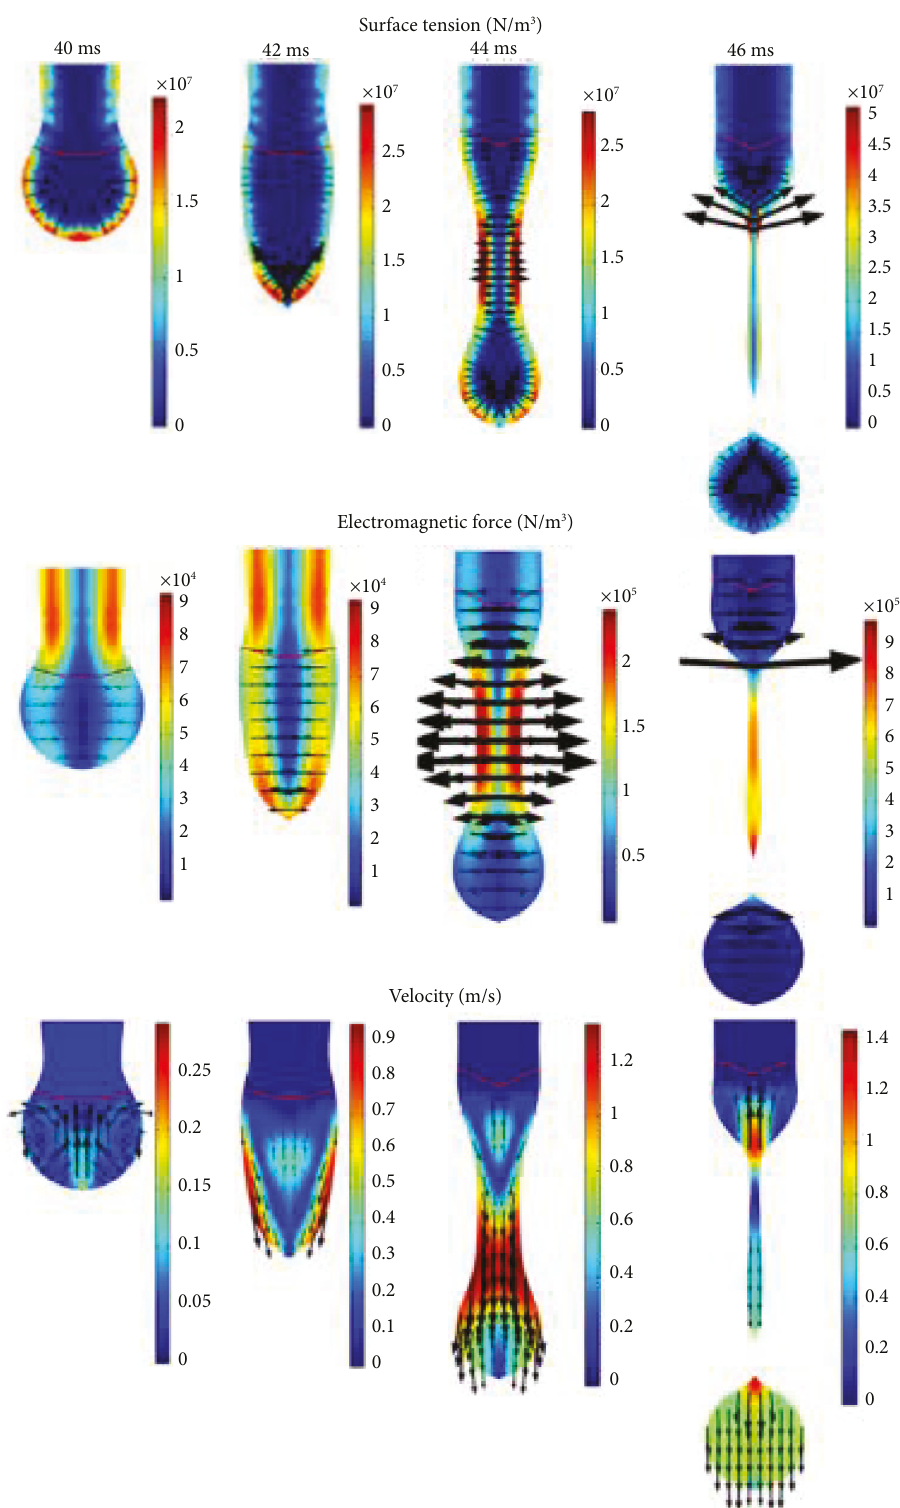
Figure 10: A sequence of the distribution of calculated process variables showing different moments during a pulse